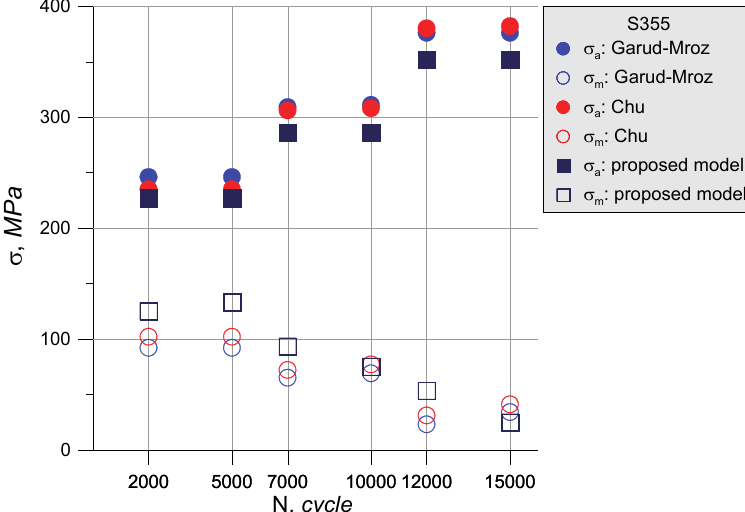
Figure 12: Comparison of the stress history parameters calculated by proposed model and models of Garud-Mroz and Chu for decreased mean load